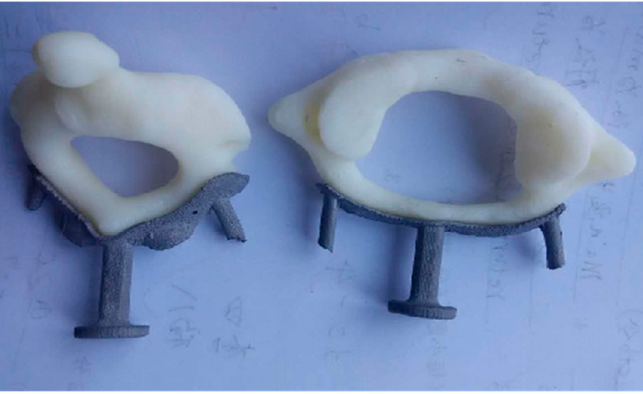
Figure 7. Fitting of the metal template and the FDM-printed cervical vertebra model.